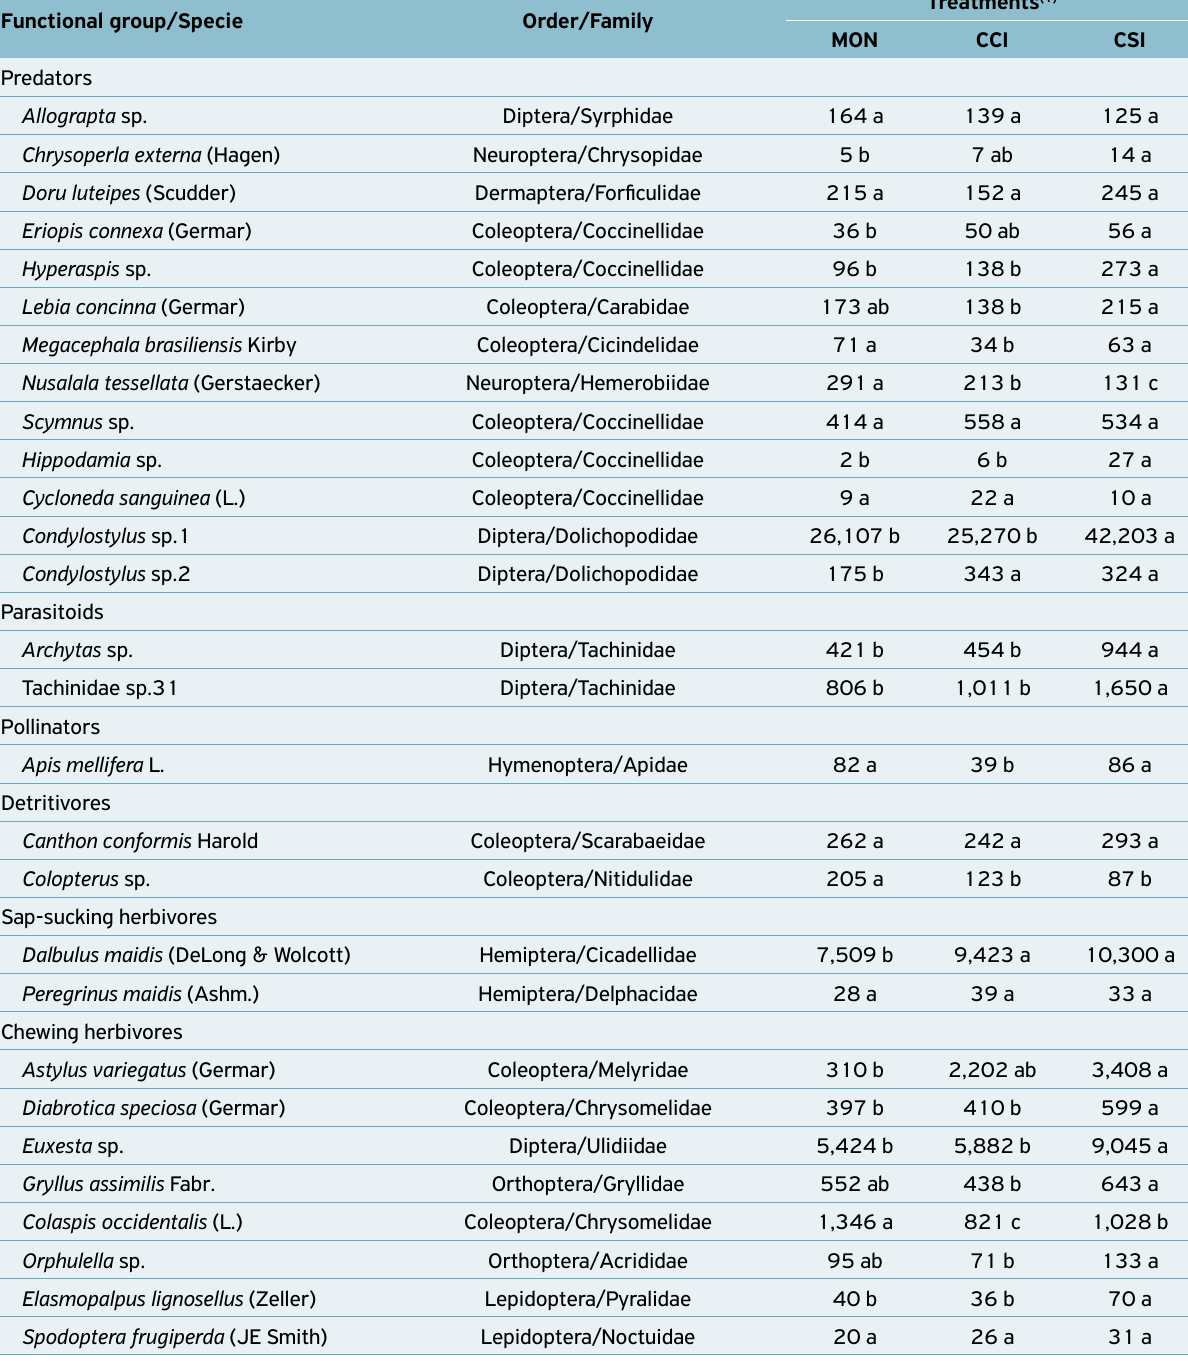
Table 3. Total number of specimens of the selected species in each functional group captured in water tray trap, pitfall trap and yellow sticky card in the treatments genetically modified maize and conventional maize with and without insecticide sprays in Ponta Grossa, PR, Brazil. Functional group/Specie